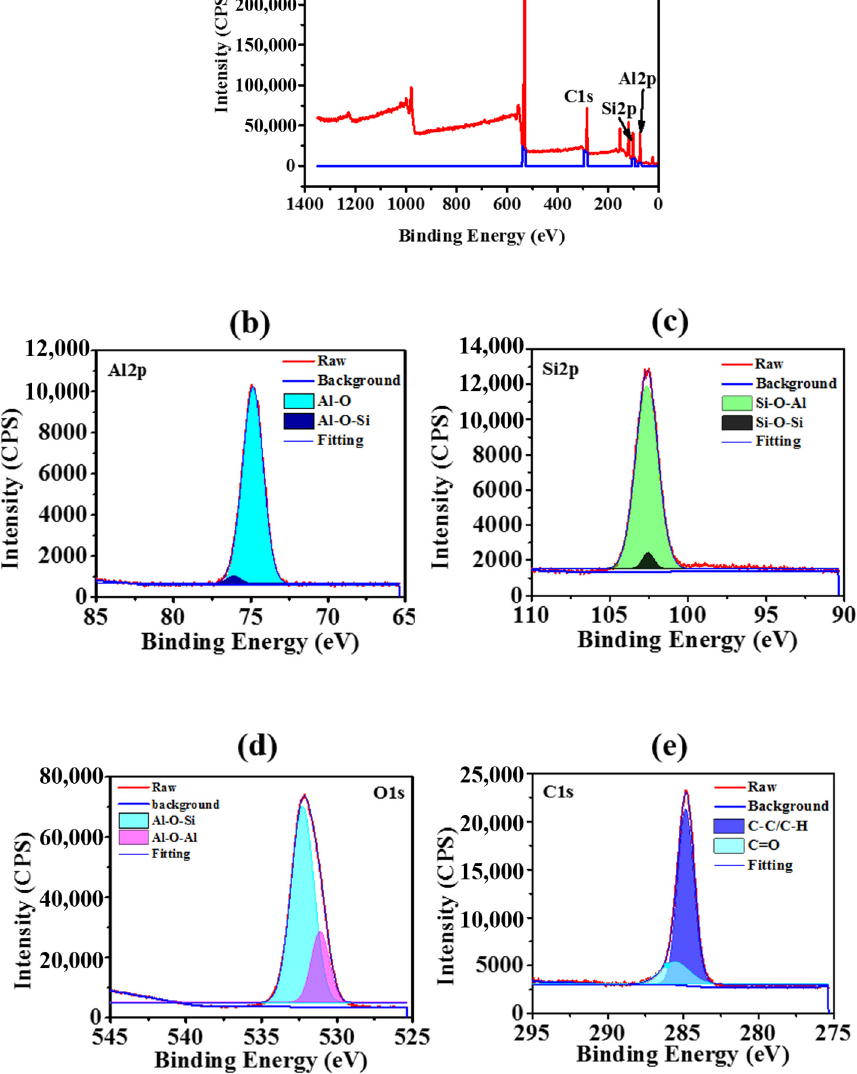
Figure 3. ( a ) XPS survey scan spectra of the superhydrophobic AD-2 coating. ( b ) Al2p peak, ( c ) Si2p peak, ( d ) C1s peak, and ( e ) O1 peak, respectively.